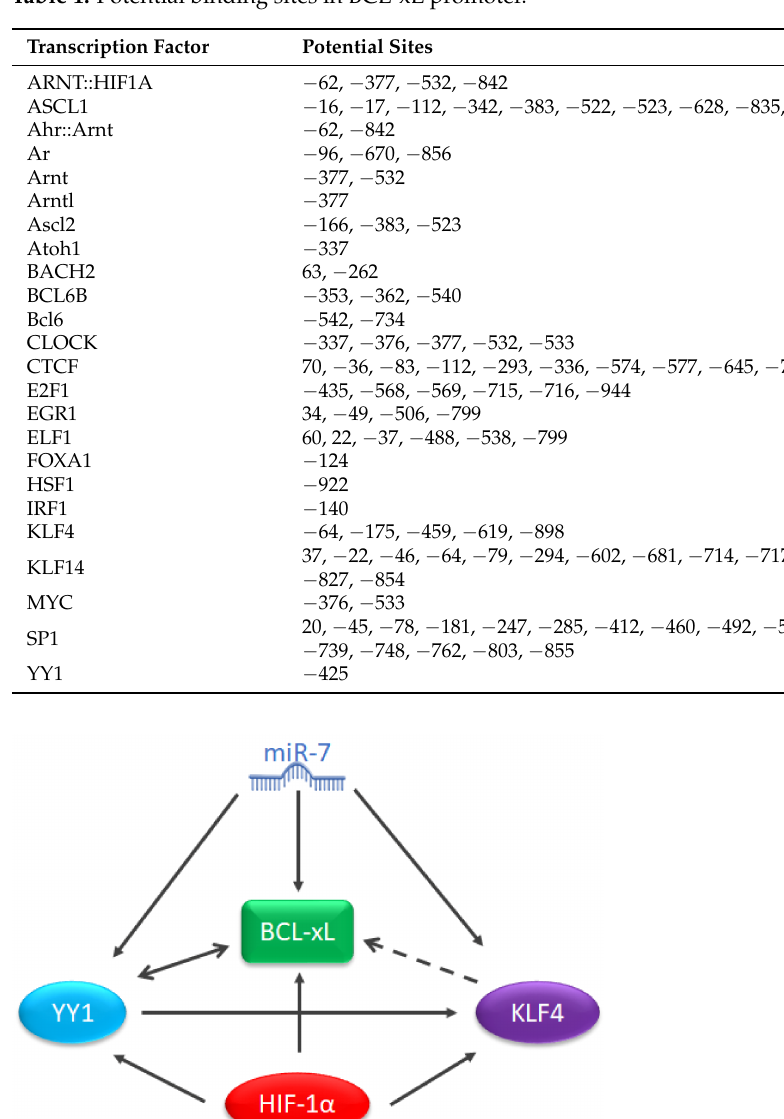
Table 1. Potential binding sites in BCL-xL promoter.